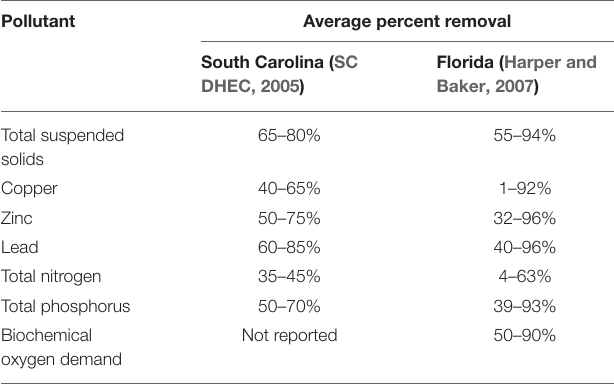
TABLE 2 | Average pollutant removal capabilities summarized in Best Management Practice manuals for wet detention ponds based on studies conducted in South Carolina and